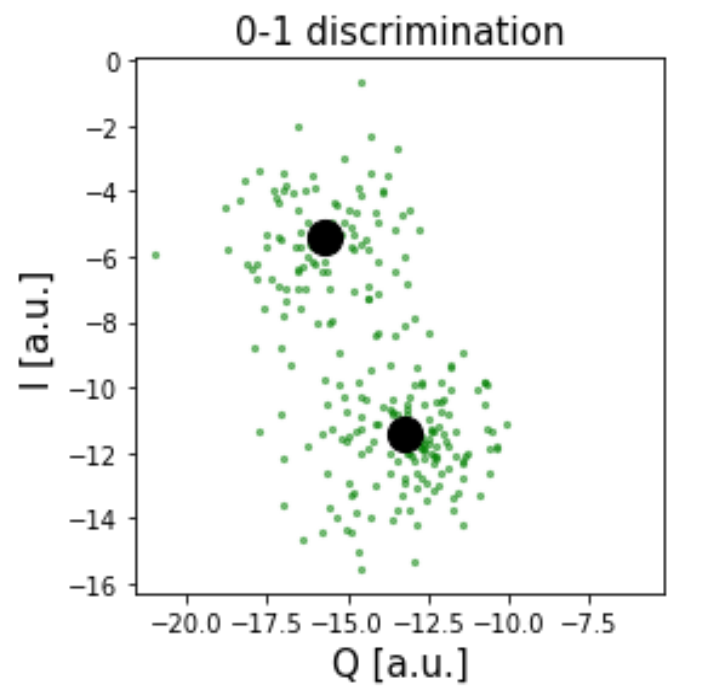
Figure 4. Scatter plots of the results obtained by driving Armonk’s qubit with the pi/2 pulse .